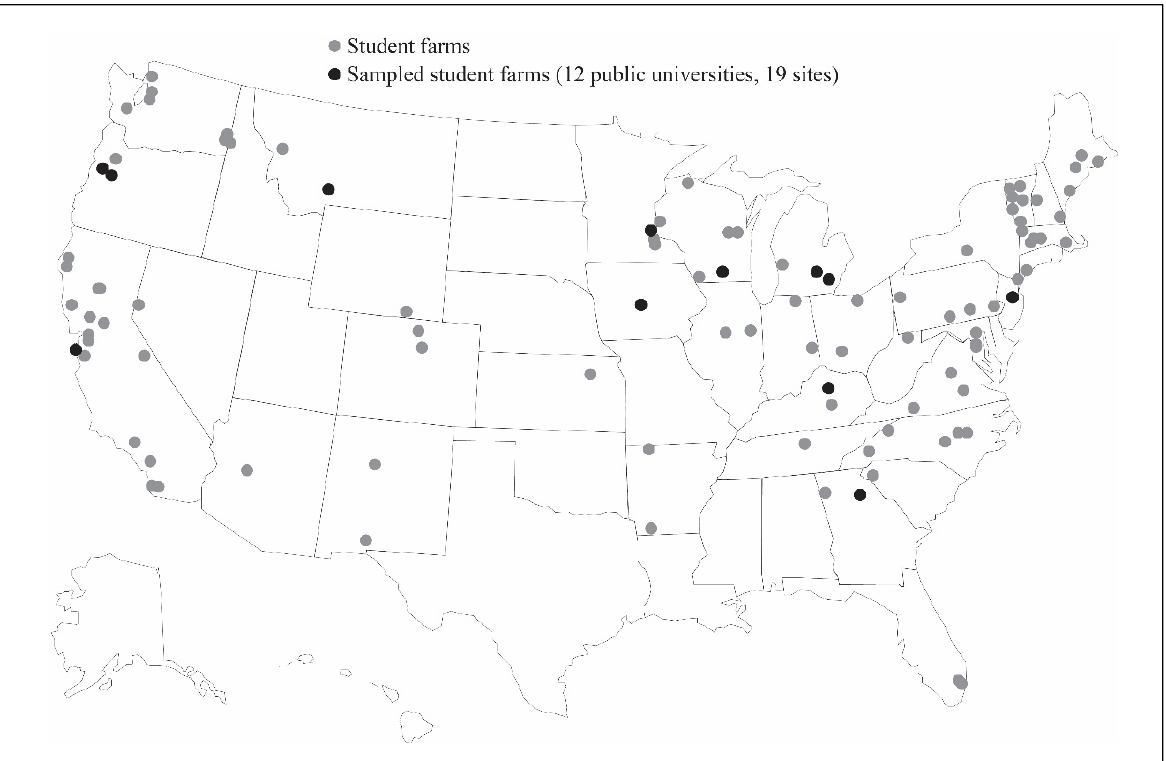
Sources: Sayre & Clark, 2011; Sustainable Agriculture Education Association,